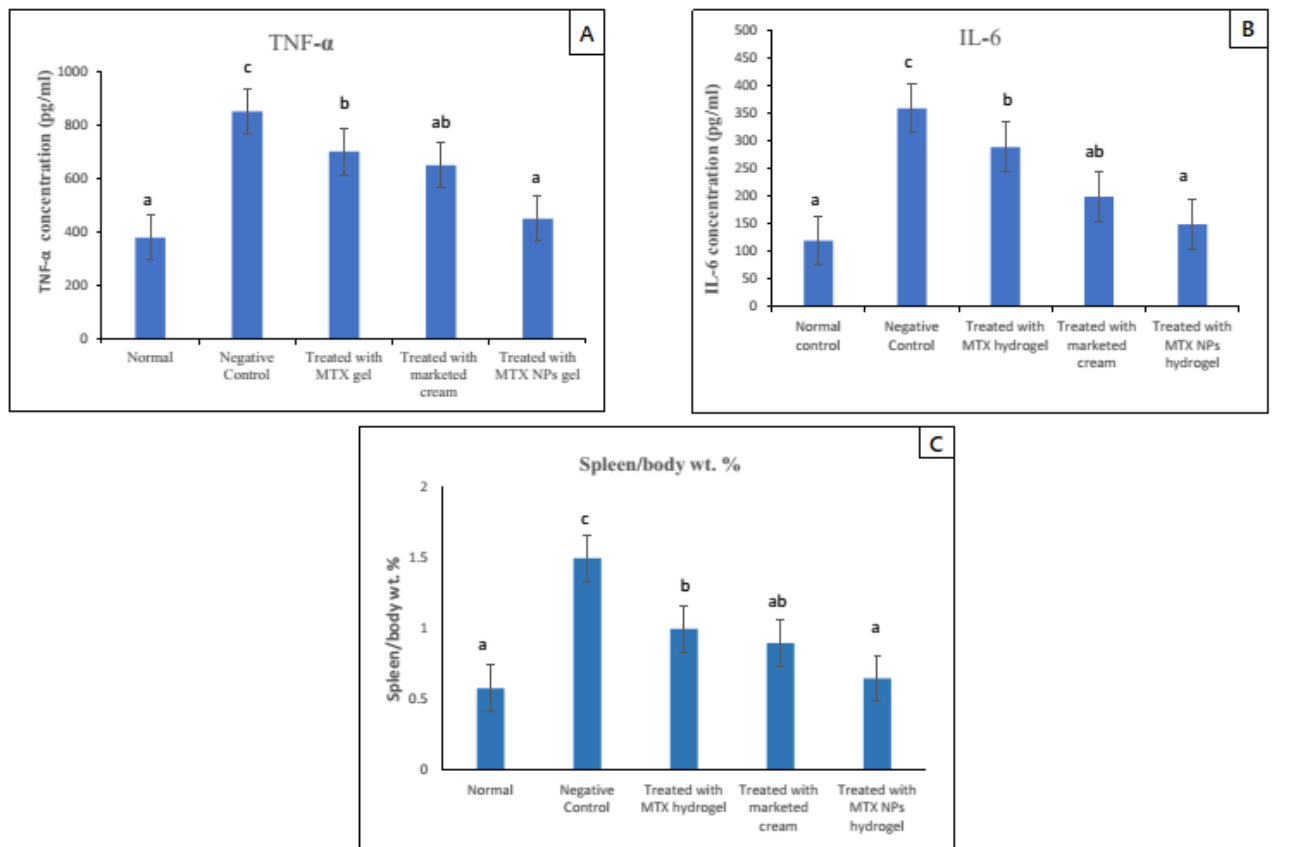
Figure 12. TNF- α and IL–6 levels in blood serum of mice from various treated groups in comparison to normal group, data has been represented as mean ± SD where different superscripts ( a – c ) represent significant difference ( p < 0.05) between various formulations i.e., a representing normal and treated with MTX-NPs loaded hydrogel, ab, group treated with marketed cream, b, treated with free MTX hydrogel and c, no treatment. Spleen to body weight was calculated after mice were sacrificed. Data has been represented as mean± SD where different superscripts ( a – c ) represent significant difference ( p < 0.05) between various formulations.